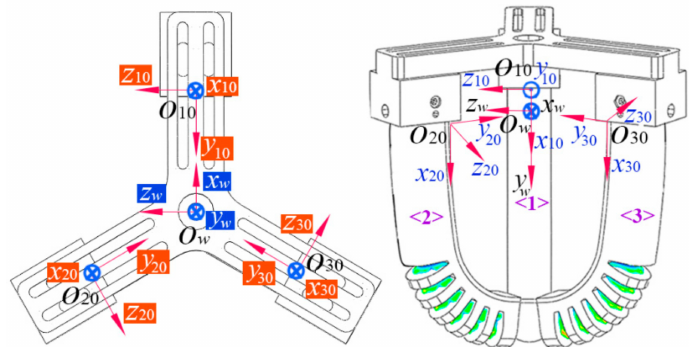
Figure 7. A three-finger soft gripper constituted by the proposed soft actuators and its coordinate system definition.